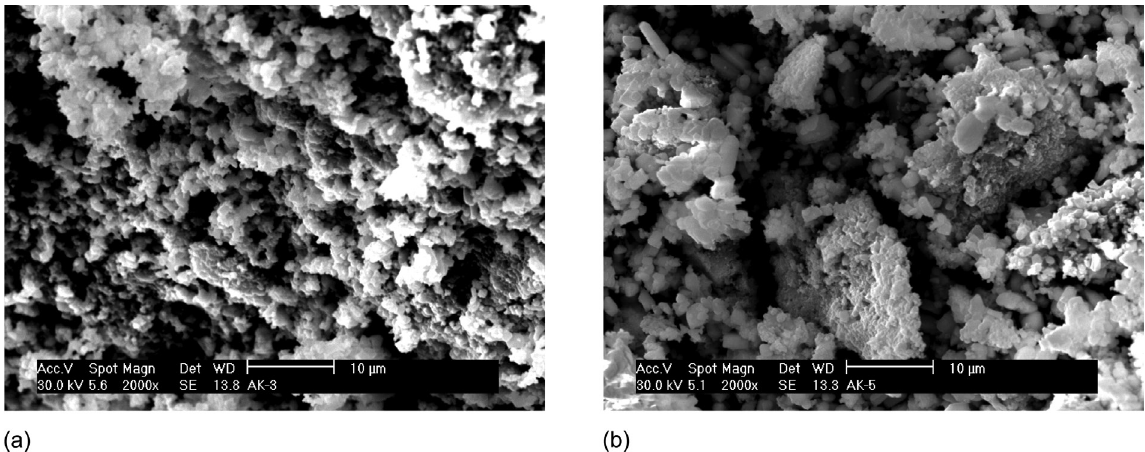
Fig. 3: Samples exposed to corrosive environment at 1000 °C (a) without V 2 O 5 in salt mixture and (b) with V 2 O 5 in salt